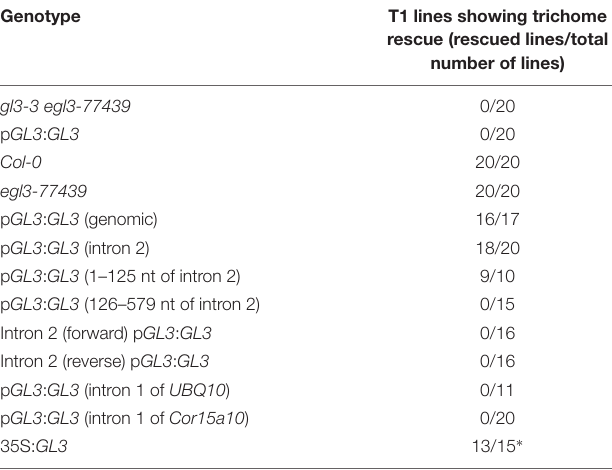
Genotype T1 lines showing trichome